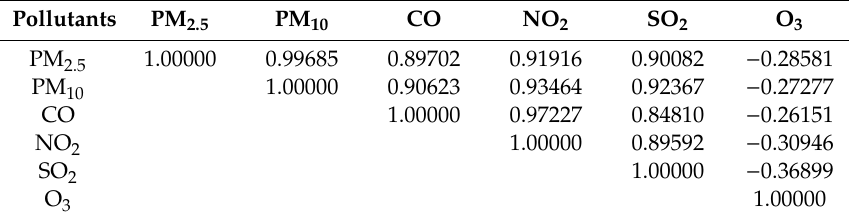
Table 3. Pearson correlation coe ffi cients for air pollutant exposures during entire